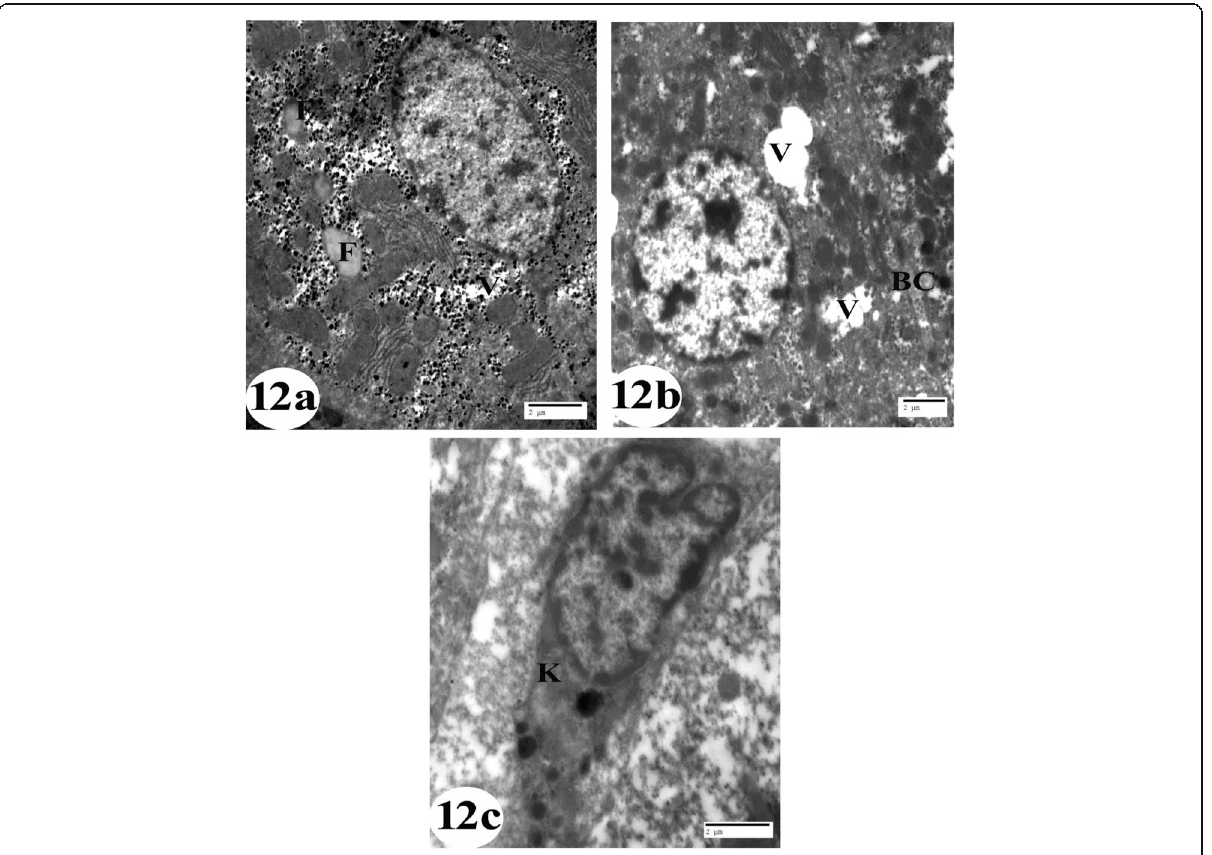
Fig. 12 Electron micrographs of a sections of liver of LCT + 100 mg ginseng/kg b. wt./day treated rats a , b showing hepatocyte except some cytoplasmic vacuolations (V), some fat droplets (F), and normal bile canaliculi (BC) (scale bar = 2 μ m). c Showing Kuppfer cell (K) (scale bar = 2 μ